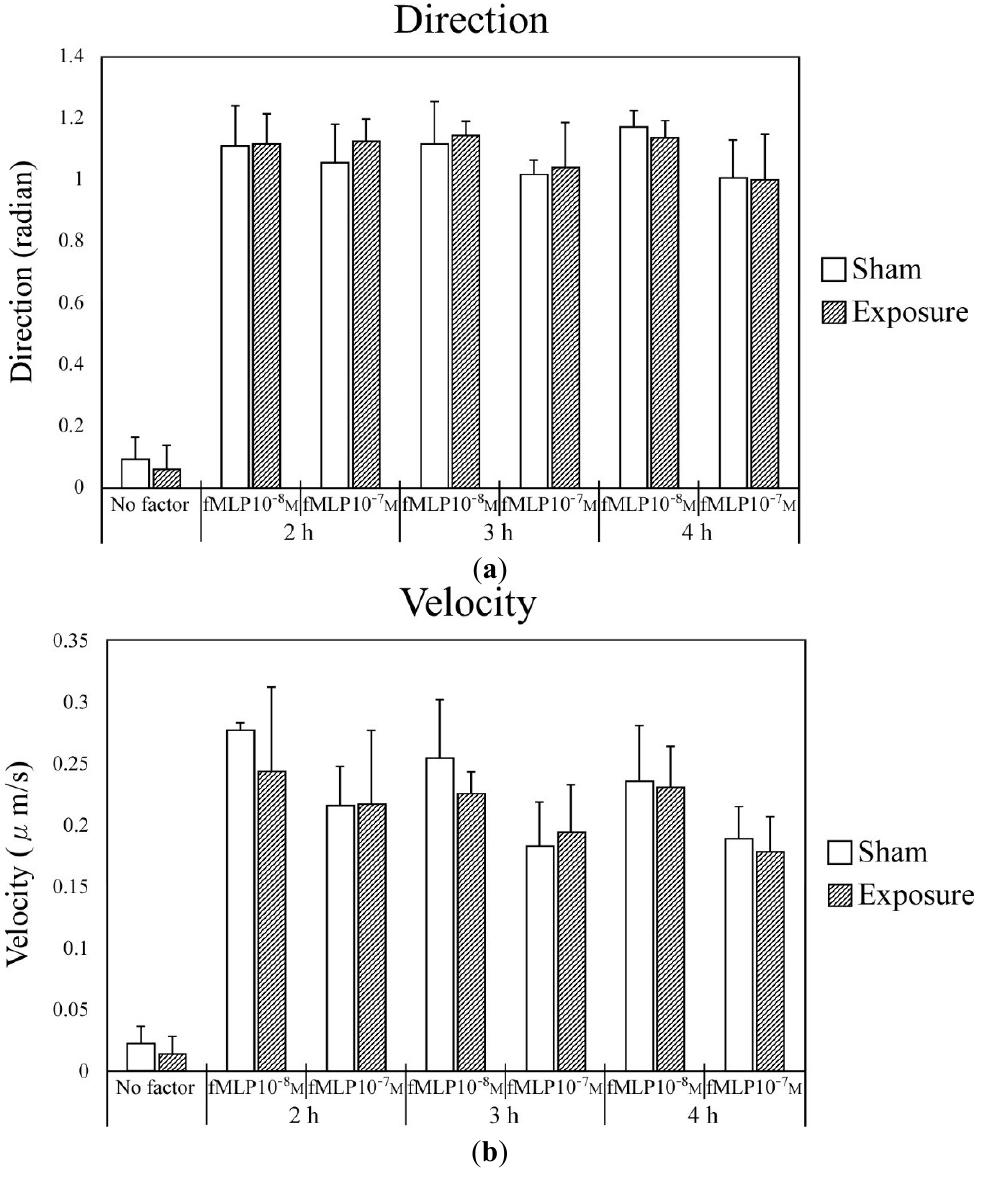
Figure 2. Chemotaxis of differentiated HL-60 cells after sham or IF magnetic field exposure for 2, 3, or 4 h. The directionality ( a ) and migration velocity ( b ) of differentiated HL-60 cell movement was assayed using 0, 10, or 100 nM fMLP as the